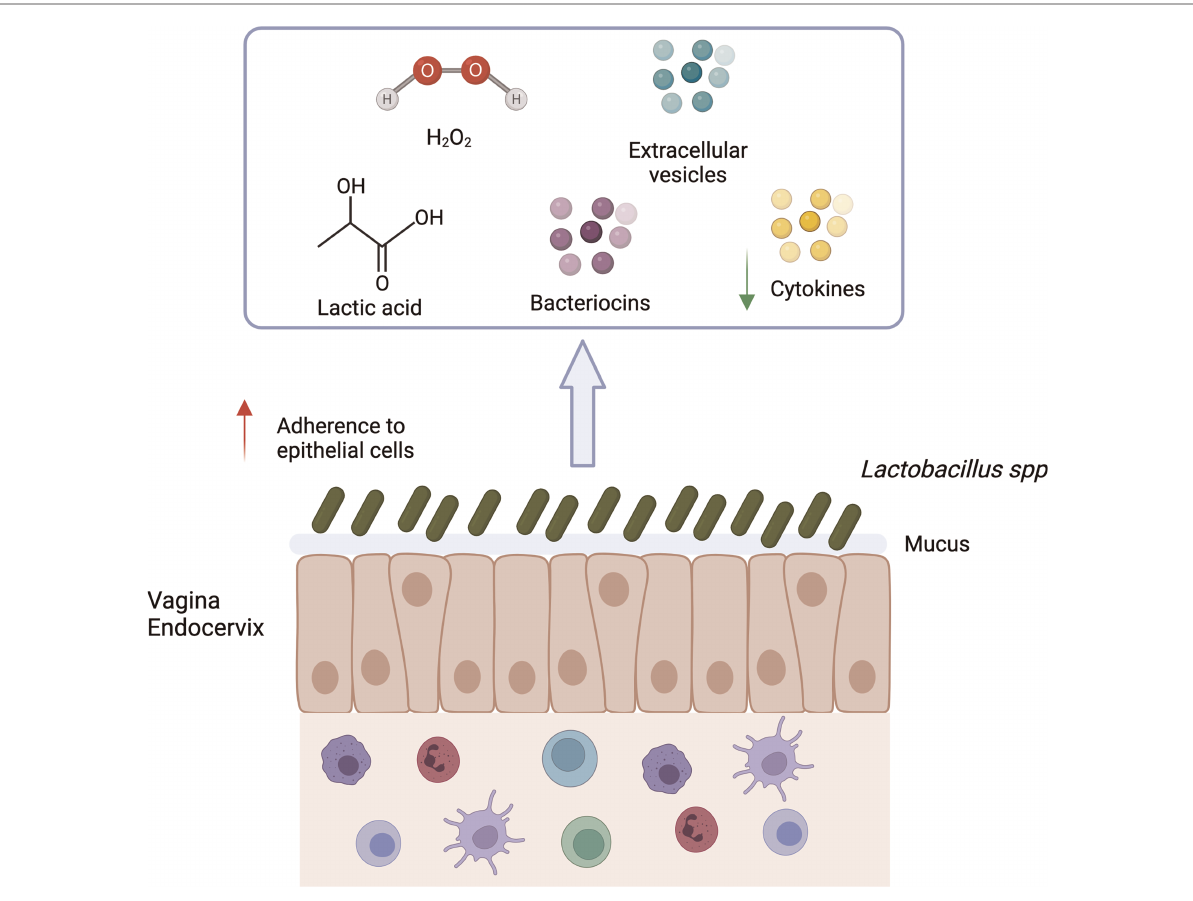
FIGURE 3 Mechanisms of action associated with Lactobacillus spp. presence. Lactobacillus spp. decrease the risk of sexually transmitted infection acquisition by several mechanisms: (1) Aggregation to epithelial cells protecting the cells from pathogen; (2) Maintenance of mucus integrity; (3) Low in fl ammation (low production of cytokine and immune cells recruitment); (4) Production of factors (lactic acid, bacteriocins, H 2 O 2 , extracellular vesicles) involved in pathogen inhibition. Created with